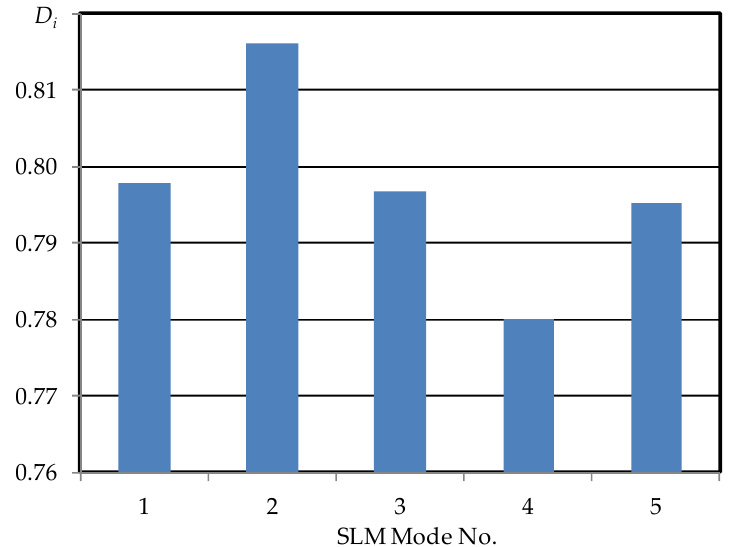
Figure 10. The generalized desirability function of quality indices for different SLM technological modes.